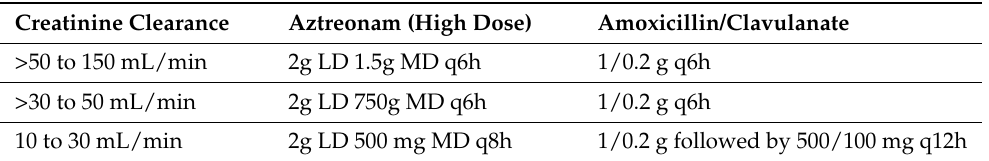
Table 1. Dosing regimens of aztreonam and amoxicillin/clavulanate as 3 h infusion used in simulation by creatinine clearance